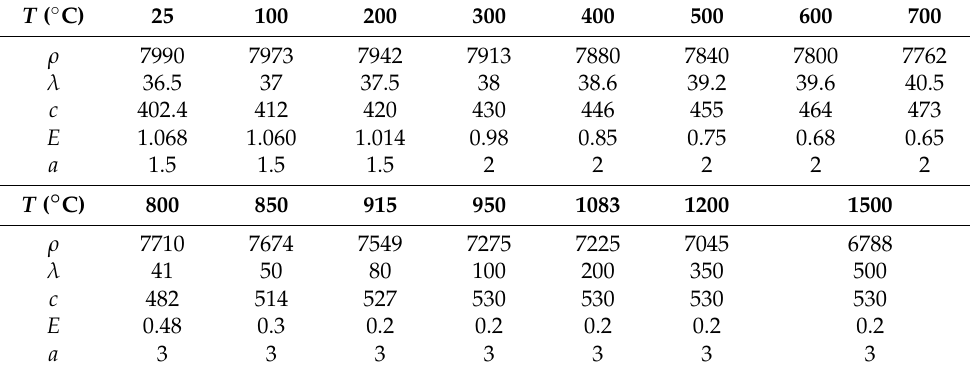
Table 2. Changes in the mechanical properties of base material at different temperatures.